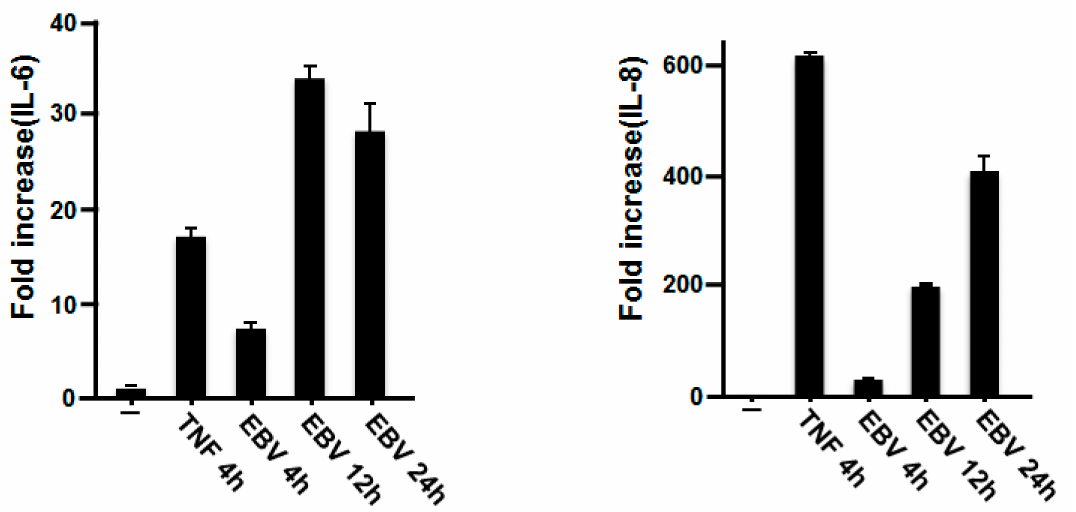
Figure 1. Effects of EBV on the expression of IL-6 and IL-8 mRNA in HGFs. HGFs were treated with inactivated EBV (5000 copies/mL) or TNF- α (1 ng/mL) for the indicated times. “-” indicates treatment with virus-treated stock solution as a control. RT-PCR analysis was performed to detect the expression of IL-6 and IL-8 mRNA with specific primers. IL-6 and IL-8 mRNA levels were normalized to glyceraldehyde-3-phosphate dehydrogenase (GAPDH) mRNA levels, and they are shown as fold increase. EBV, Epstein–Barr virus; IL, interleukin; HGFs, human gingival fibroblasts; TNF- α , tumor necrosis factor- α ; RT-PCR, real-time polymerase chain reaction; GAPDH, glyceraldehyde-3-phosphate